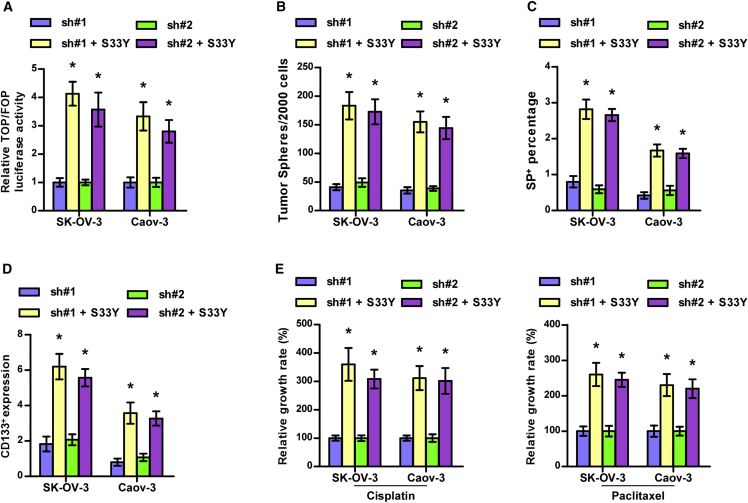
Silencing LGR6 Represses Stemness and Chemoresistance via Inhibiting Wnt/β-Catenin Signaling(A) S33Y reversed the inhibitory effects of LGR6 silencing on activity of Wnt/β-catenin signaling. Error bars represent the mean ± SD of three independent experiments. *p < 0.05. (B–D) S33Y reversed the inhibitory effects of LGR6 silencing on spheroid formation ability (B) and SP+ (C) and CD133+ (D) populations of ovarian cancer cells. Error bars represent the mean ± SD of three independent experiments. *p < 0.05. (E) S33Y reversed the inhibitory effects of LGR6 silencing on chemoresistance of ovarian cancer cells to cisplatin and paclitaxel. Error bars represent the mean ± SD of three independent experiments. *p < 0.05.